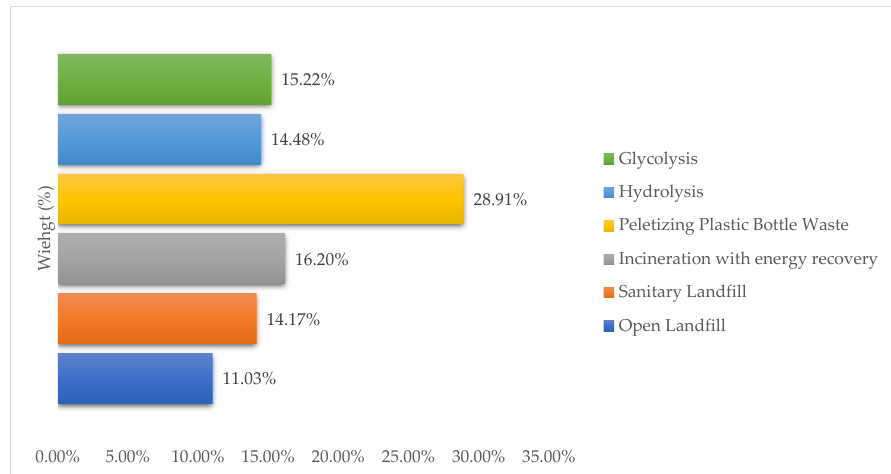
Figure 9. Alternatives’ priorities (%).